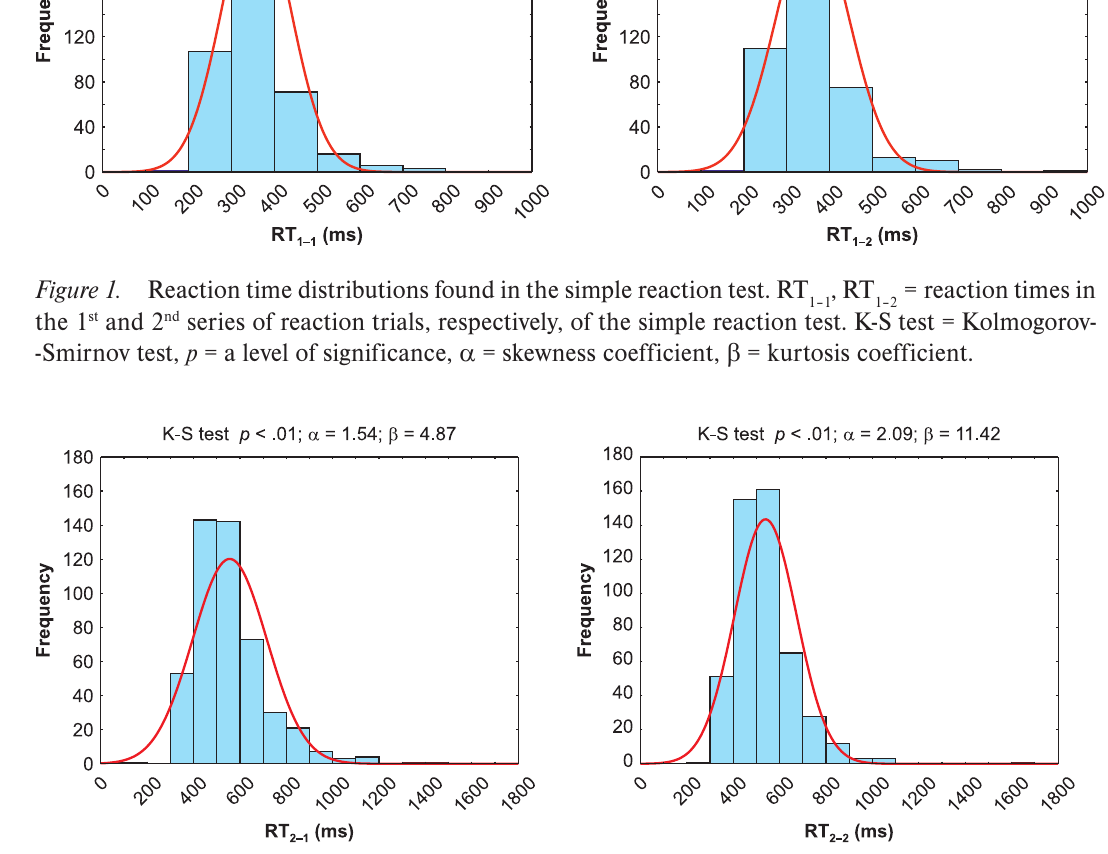
Figure 2. Reaction time distributions found in the two-choice reaction test. RT times in the 1 st and 2 nd series of reaction trials, respectively, of the simple reaction test. K-S test = Kol- mogorov-Smirnov test, p = a level of significance, α = skewness coefficient, β = kurtosis coefficient.